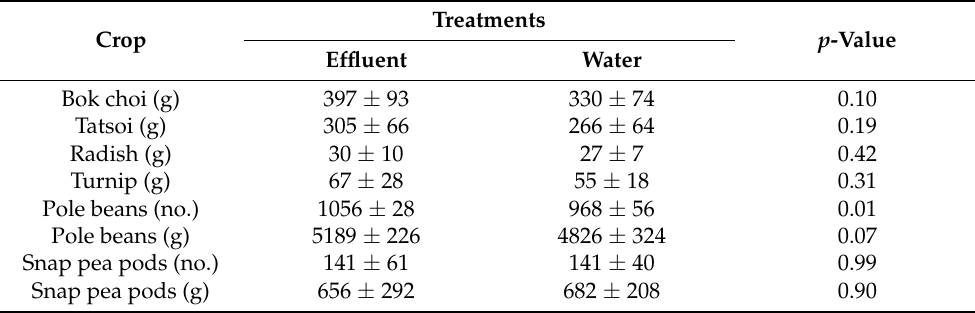
Table 2. Mass (g) of four spring crops and number and mass (g) of two fall crops irrigated with either aquaculture effluent or